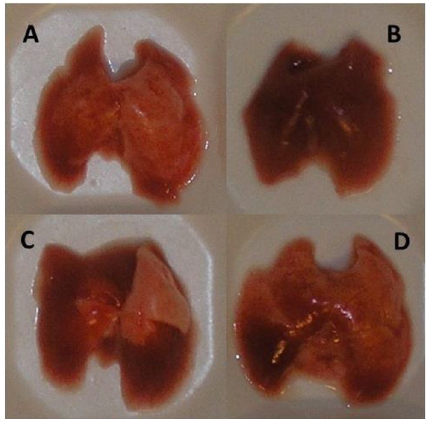
Figure 5. Representative macroscopic appearance of the lungs in preterm newborn rabbits after administration of saline and poractant alfa ( A ), LPS and no further treatment ( B ), LPS and poractant alfa ( C ), and LPS and poractant alfa with PxB ( D